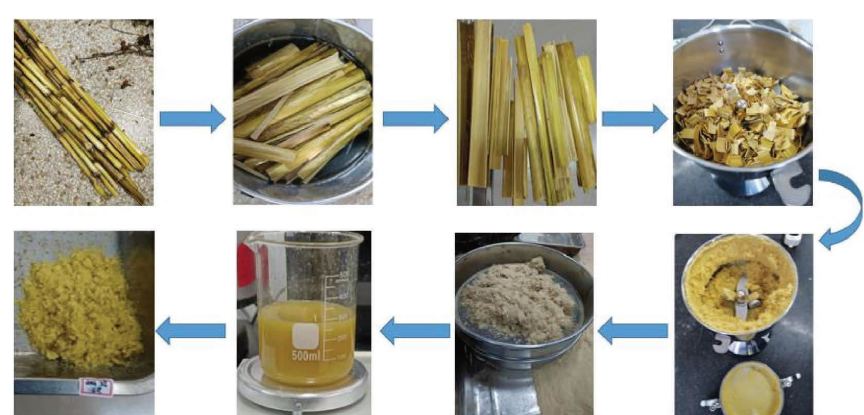
Figure 1: Flowchart of the